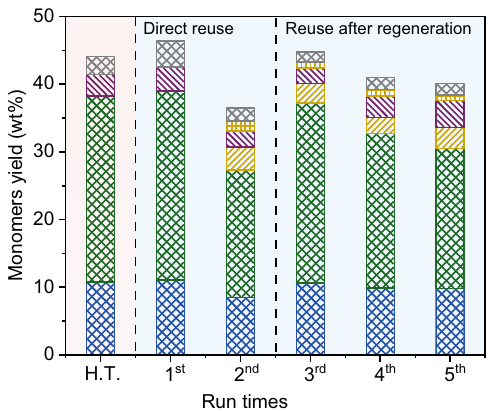
Fig. 7 | RCF of various biomass sources. Reaction conditions: biomass sawdust (250mg), RuN/ZnO/C (25mg, 10wt%), MeOH (15mL), 240°C, H 2 (3MPa at 25°C, 12MPa at 240°C), and 4h. CA-H and FA-H represent methyl 3-(4-hydroxyphenyl) propanoate and methyl 3-(4-hydroxy-3-methoxyphenyl)propanoate,